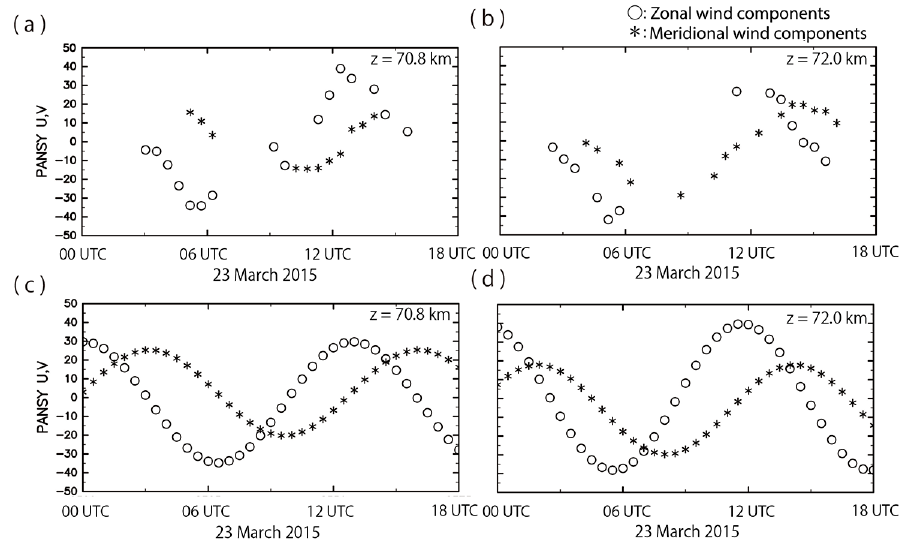
Figure 4. Zonal and meridional wind components observed by the PANSY radar on 23 March 2015 as a function of time at heights of (a) 70.8km and (b) 72.0km. Zonal and meridional wind components fitted sinusoidal functions using a nonlinear least-squares method at the height of (c) 70.8km and (d) 72.0km. The circles denote the zonal wind components and the star marks denote the meridional components.